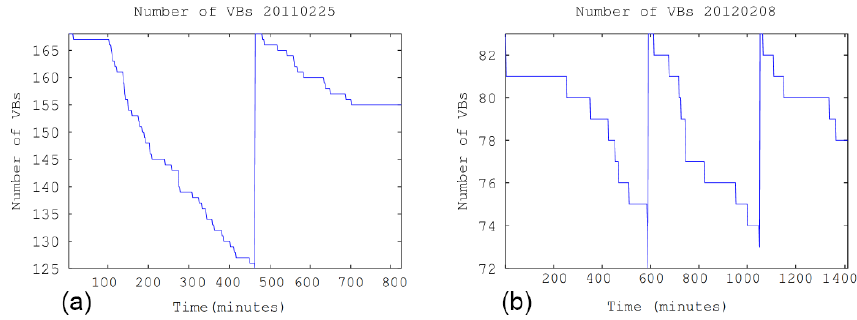
Figure 10. Number of VBs at each time step for the 2011 case (a) and for the 2012 case (b) . The threshold to add new VBs was 75 and 90% of the original number of VBs respectively.